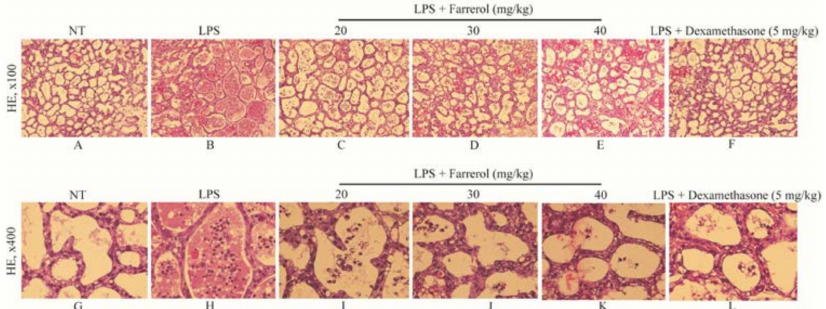
Figure 2. Effects of farrerol on the pathological changes of mammary gland (( A – F ), × 100 and ( G – L